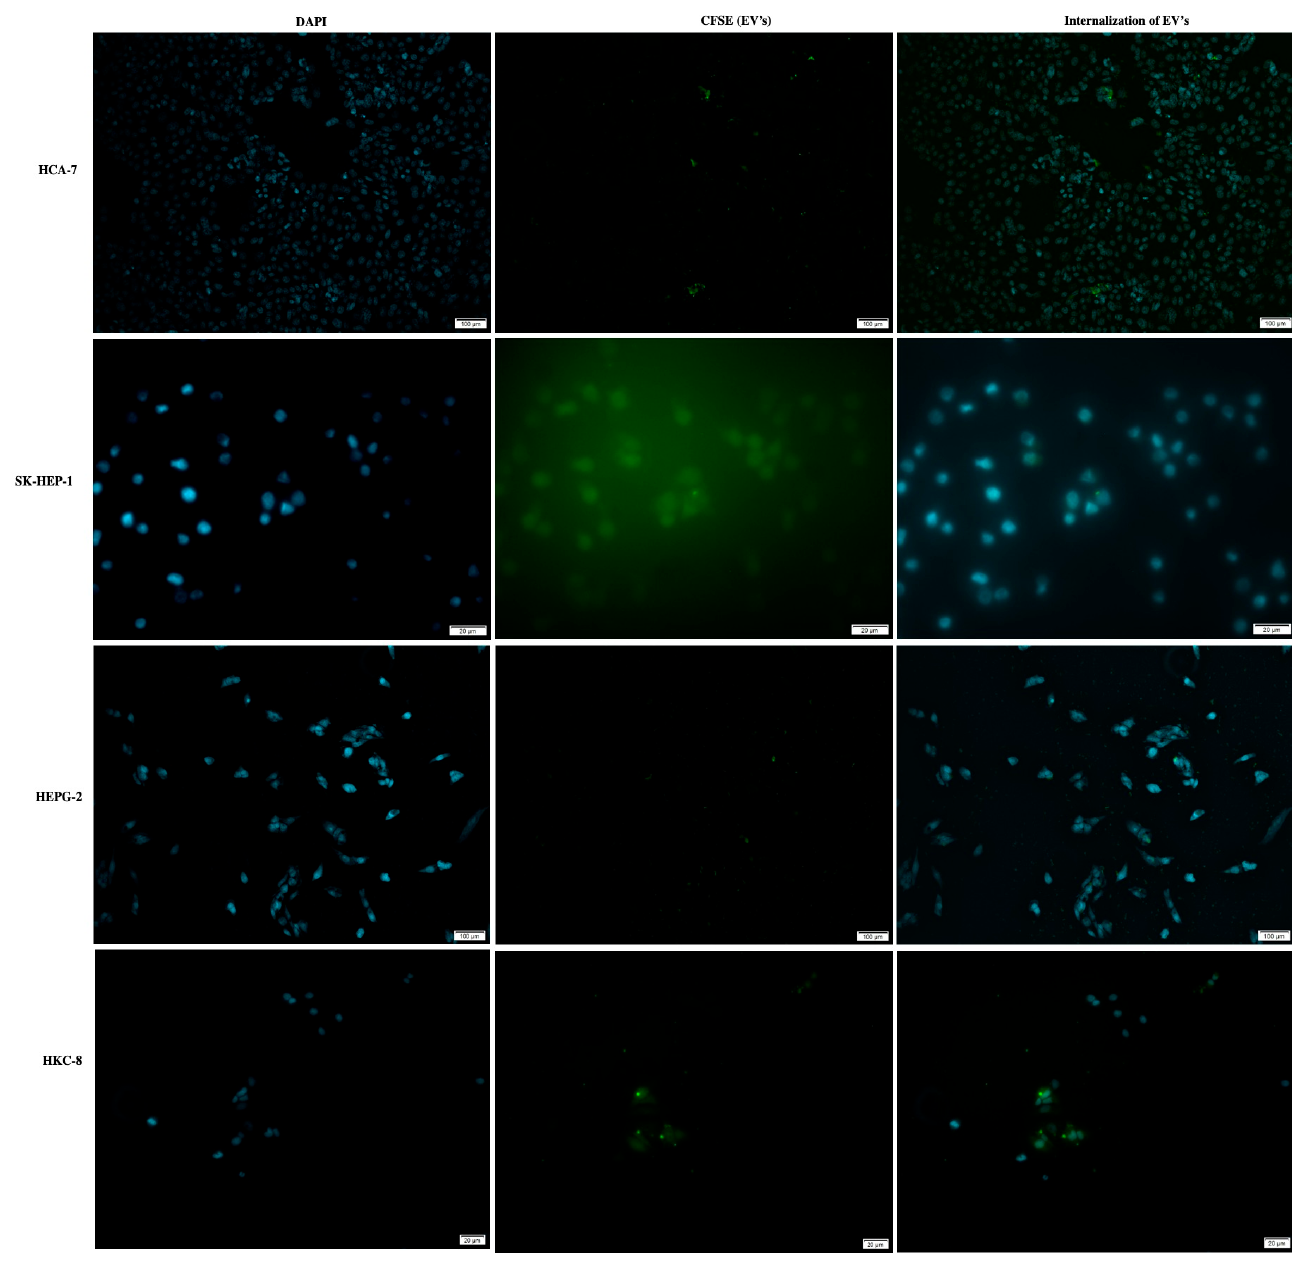
Figure 3. Representative immunofluorescence image shows the internalization of HCT 116-EVs labeled with CFSE (green dye) by HCA-7, SK-HEP-1, HEPG-2 and HKC-8 cells. The cell’s nucleus is stained with DAPI (blue dye). (10X Olympus ® IX51 microscope).